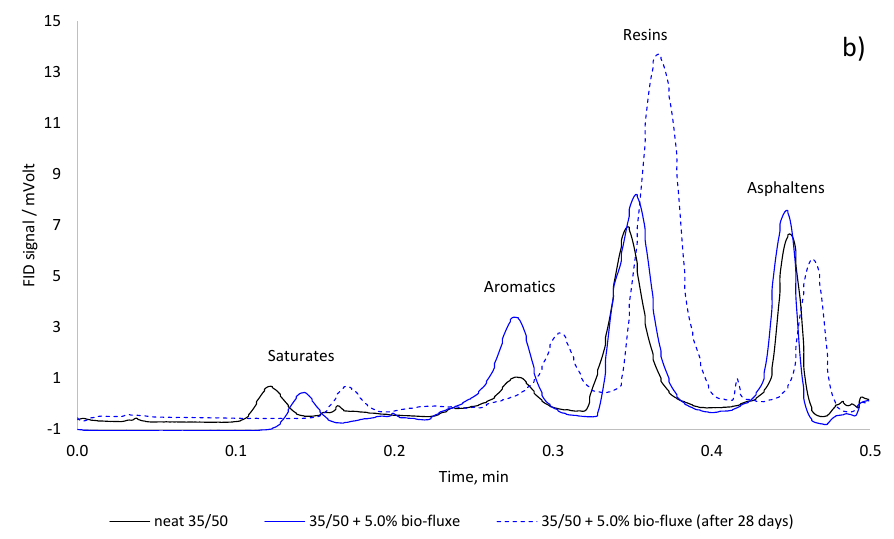
Figure 4. TLC-FID chromatograms of neat bitumen and fluxed bitumen by rapeseed oil methyl ester: ( a ) 70/100 bitumen; and ( b ) 35/50 bitumen.